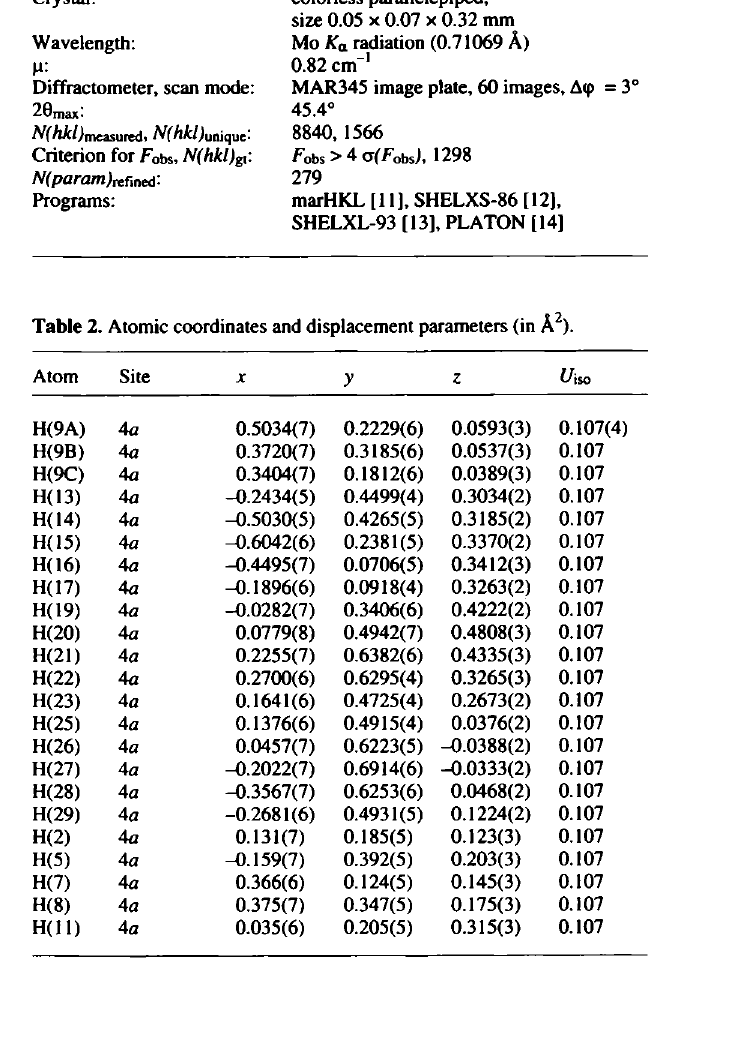
Table 1. Data collection and handling.